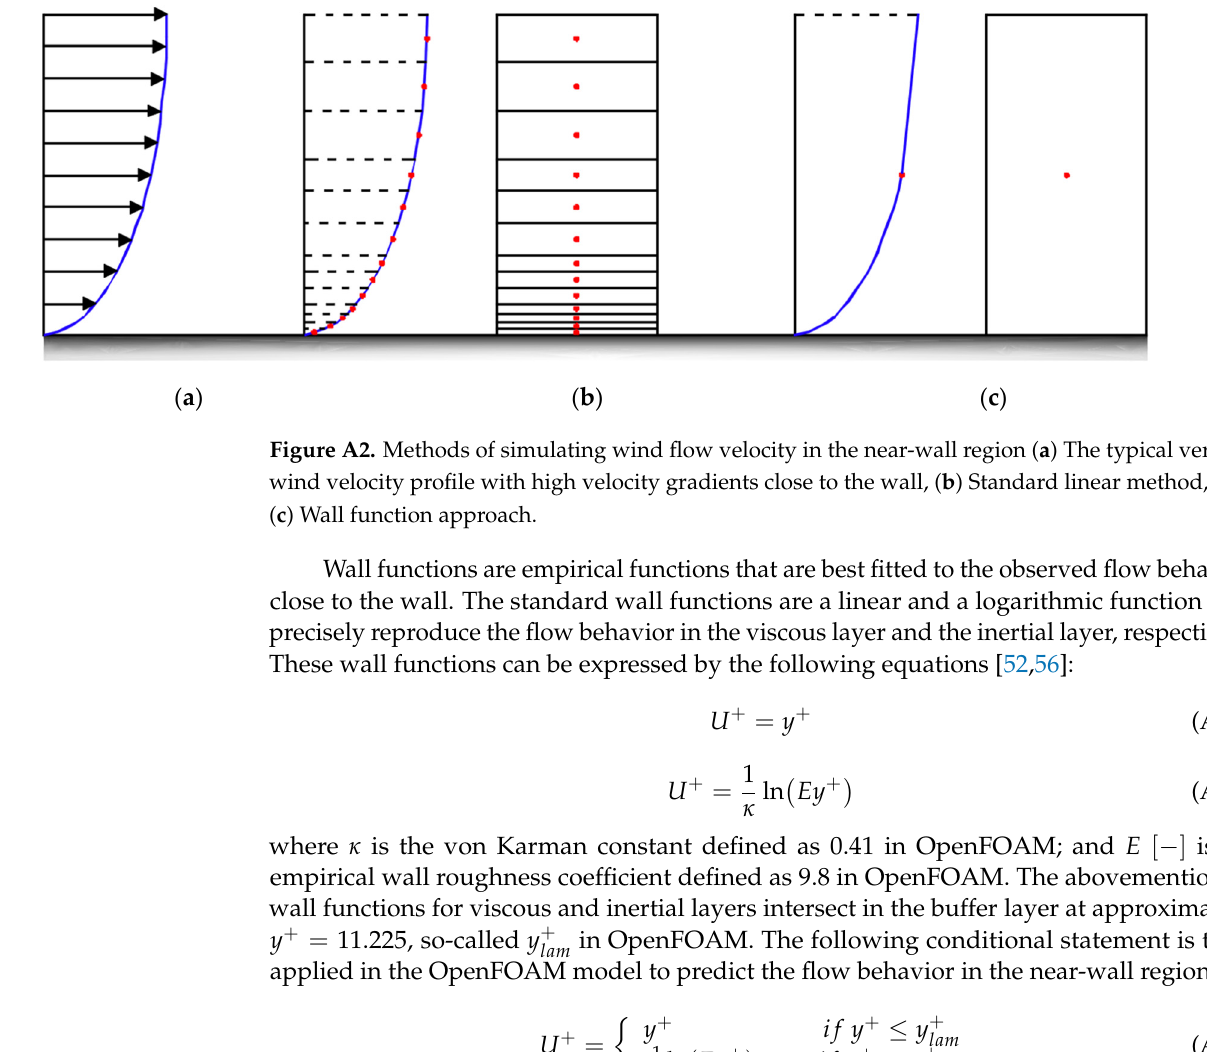
Figure A1. The analytical inflow conditions of ( a ) mean wind speed, ( b ) turbulence kinetic energy, 𝑘 , and ( c ) turbulence dissipation rate, 𝜀 .